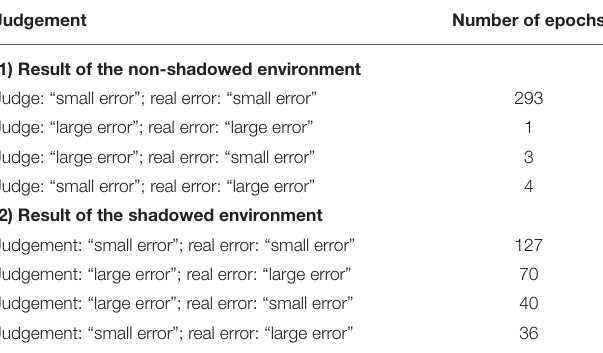
TABLE 5 | Results of evaluation of the method using mileage and distance between positioning points. Judgement Number of